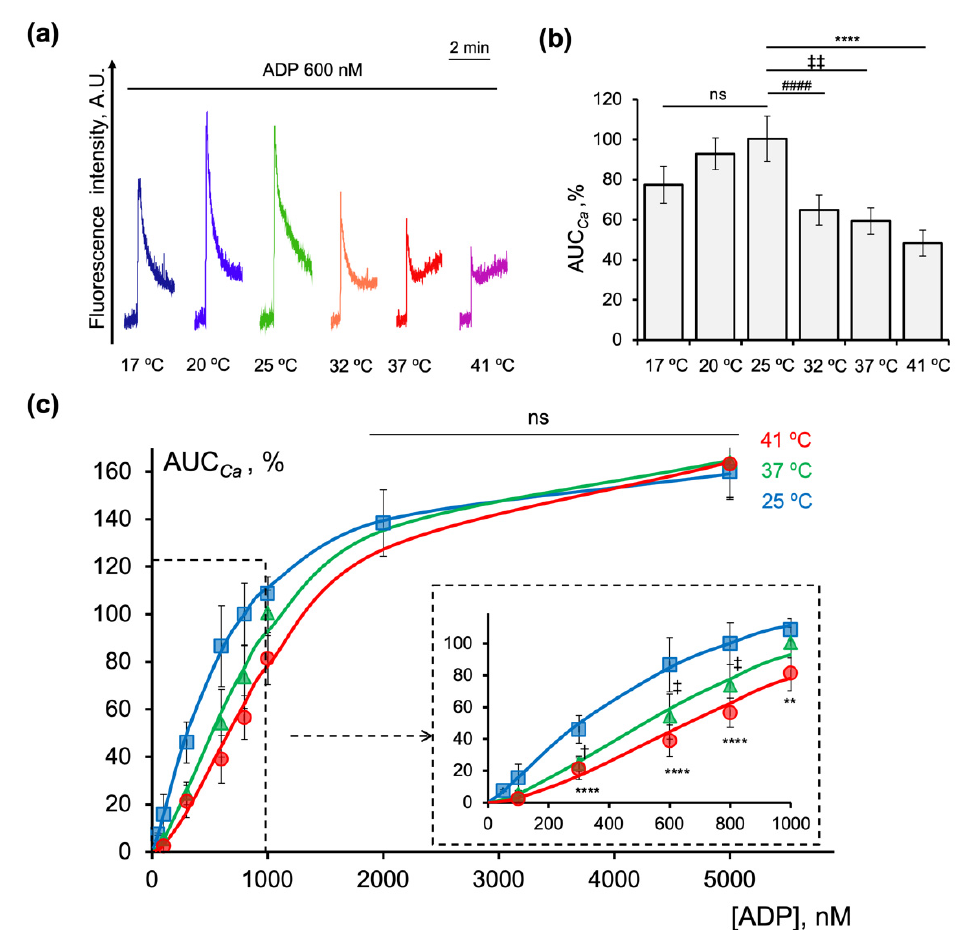
Figure 7. [Ca 2+ ] i decreased significantly with the temperature rise. PRP was stained with Fluo-3 AM (5 µ M, 30 min, RT), diluted in HEPES buffer (1 × 10 7 platelets/mL), and added to the cuvette with continuous stirring (1200 rpm) at indicated temperatures. After 2 min of incubation, ADP (600 nM) was added, and [Ca 2+ ] i was assessed in dynamics according to the Fluo-3 fluorescence registered at FL1 (527 nM). ( a ) Representative traces from four independent experiments; ( b ) quantification of the data presented in ( a ); ( c ) dose-response curves of AUC Ca plotted against ADP concentration. For all calculations, the AUC Ca for 800 nM ADP-stimulated platelets at 25 °C was taken as 100%. Points indicate the normalized AUC Ca data, and continuous lines represent fits of the Hill equation to the experimental data. The dose-dependency of AUC Ca at the low concentrations of ADP (from 5 to 1000 nM) is emphasized in the separate box. Data are presented as means ± SD, n = 8; for ( b ) one-way ANOVA, Tukey’s post-hoc; ns: not significant; ****, p < 0.0001 (25 °C vs. 41 °C), ‡‡ , p < 0.0001 (25 °C vs. 37 °C), #### , p < 0.0001 (25 °C vs. 32 °C). For ( с ) two-way ANOVA, Tukey’s post-hoc; †, p < 0.05, ‡, p < 0.0001 (37 °C vs. 25 ° С ); **, p = 0.0063, ****, p < 0.0005 (41 °C vs. 25 ° С ). Table 4. Calculated values of AUC Ca max , EC 50 , and Hill coefficient (h) for 25°, 37°, 41 °C. Test Temperature AUC Ca max , % EC 50 (Ca 2+ ), nM h (Ca 2+ )